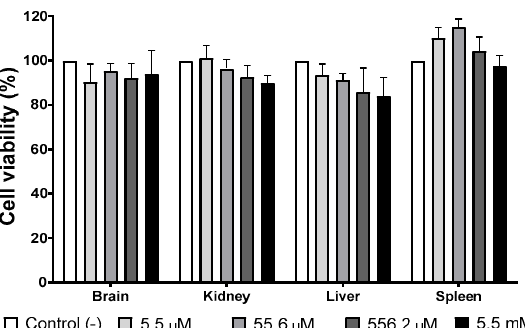
Figure 4. AgNPs’ effect on selected primary cultures cell viability. Brain, kidney, liver, and spleen primary cultures obtained from BALB/c mice were exposed to 5.5 µM, 55.6 µM, 556.2 µM, and 5.5 mM (0.6, 6, 60, and 600 µg/mL) for 24 h. For each cell type, the primary culture without treatment was used as a negative